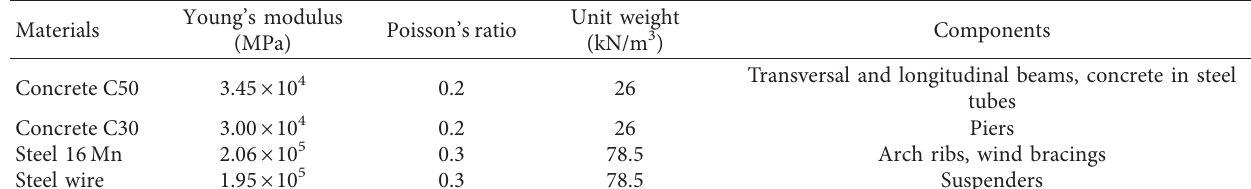
Table 1: The basic information about the materials.